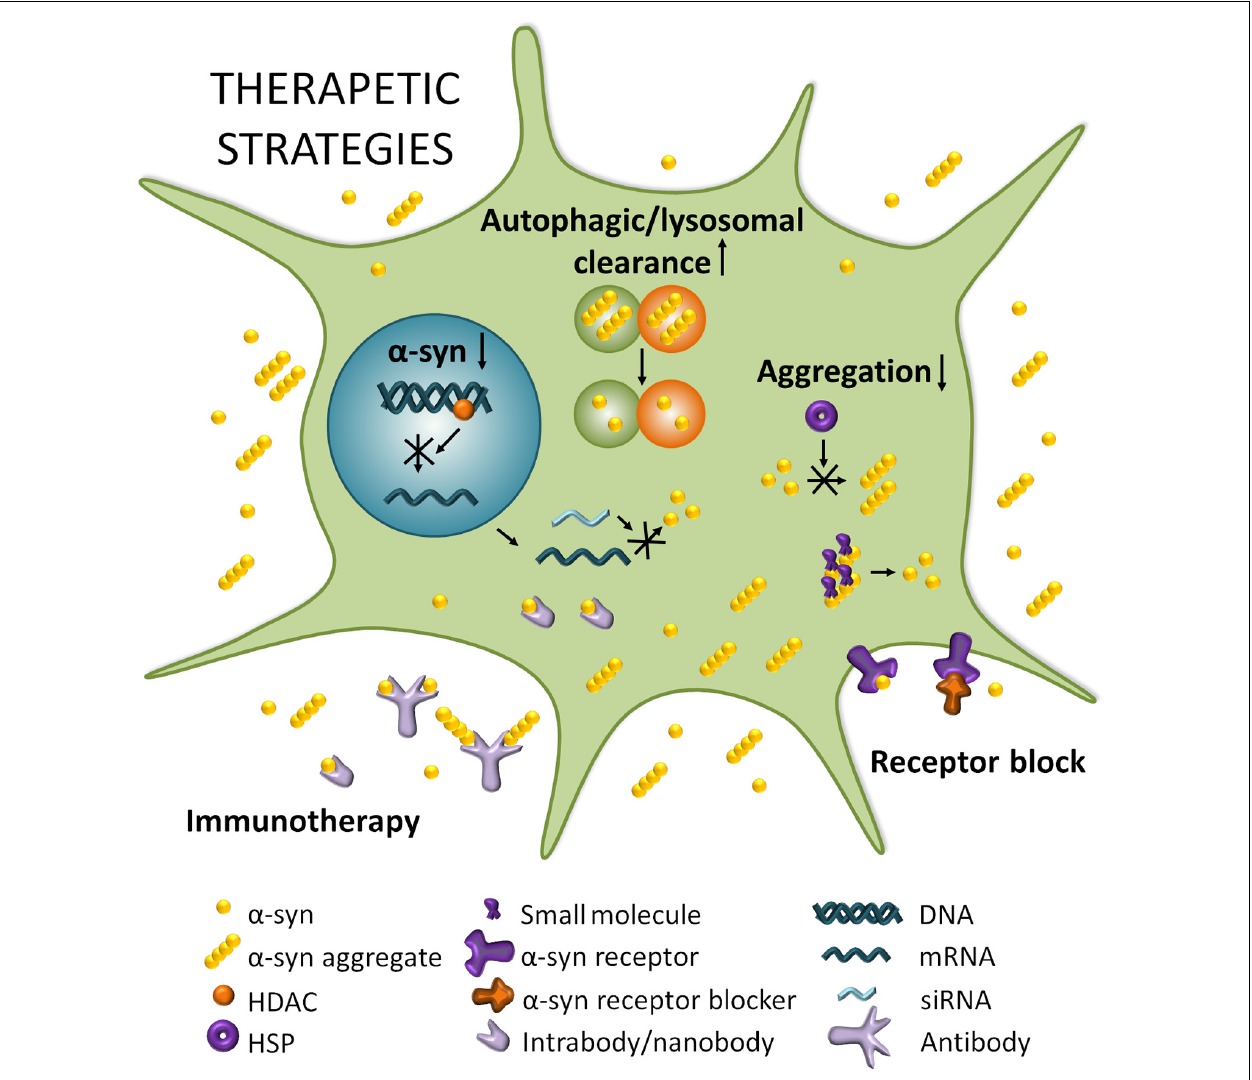
FIGURE 2 | Therapeutic strategies for PD. Boosting autophagic/lysosomal clearance is a potential avenue for clearing α -syn and other aggregating proteins that disrupt cellular homeostasis. Reducing SNCA mRNA by modulating histone deacetylase (HDACs) or through RNA interference (RNAi) strategies can potentially lead to a decrease in expression of α -syn which is known to result in reduced aggregation and toxicity. Reducing aggregation can be achieved by impeding the multimerization of α -syn through heat shock proteins (HSPs) for example, or by dissociating existing aggregates with small molecules. Blocking α -syn entry through receptor blocking would directly target the spread of α -syn and prevent its transport from cell to cell. Finally, immunotherapy could potentially neutralize α -syn and/or α -syn aggregates extracellularly and perhaps even intracellularly in the case of